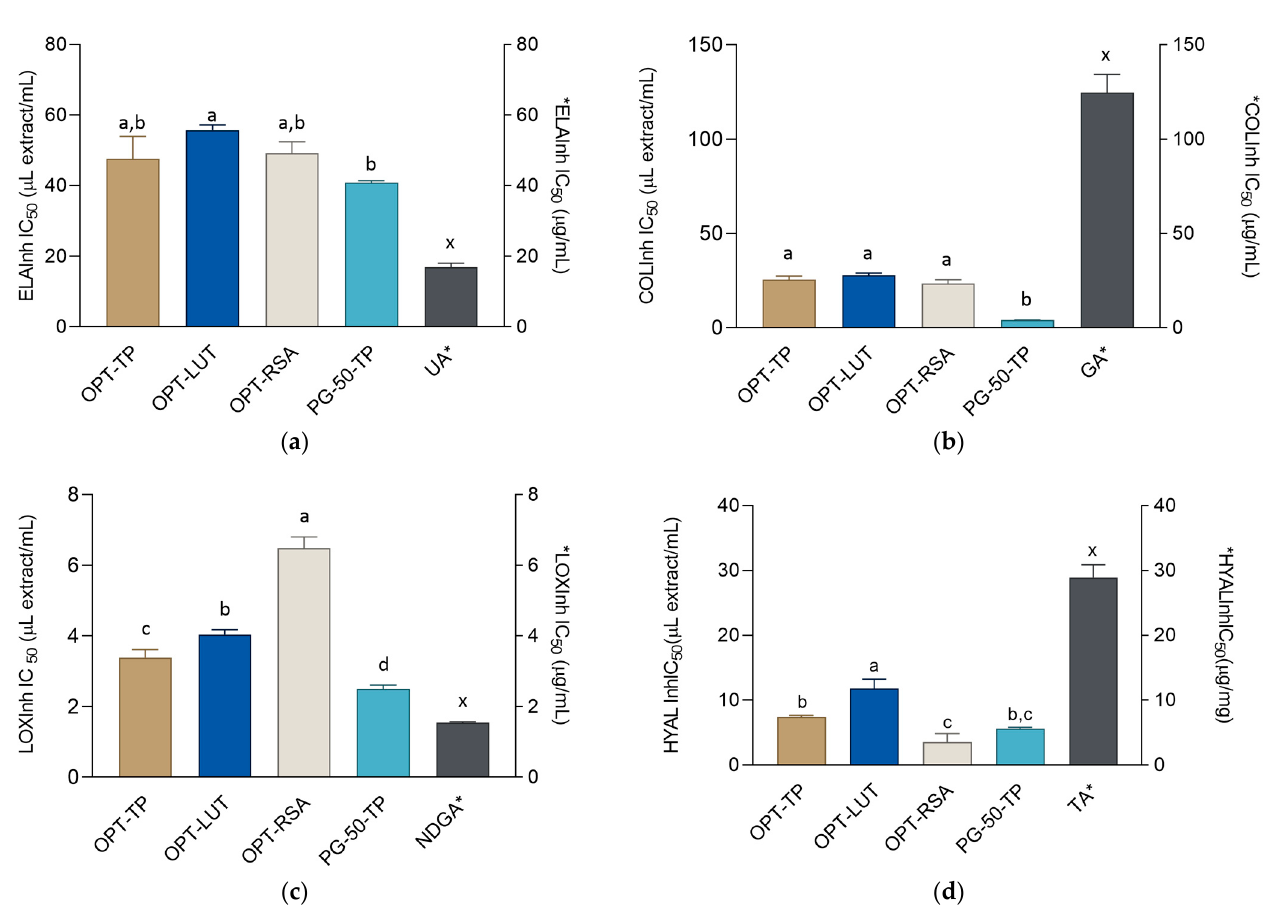
Figure 3. Inhibitory activity of the extracts and corresponding positive controls: ursolic acid (UA), gallic acid (GA), nordihydroguaiaretic acid (NDGA), and tannic acid (TA) on: ( a ) elastase, ( b ) collagenase, ( c ) lipoxygenase, and ( d ) hyaluronidase. The activities are shown as IC 50 values ± SD. a–d = differences between the extracts within a column (Tukey post-test, p < 0.05). x = differences with the positive control (Dunnett’s post-test, p < 0.05). Columns not connected with the same letter are statistically different. Asterisk indicates that the unit is placed at the right